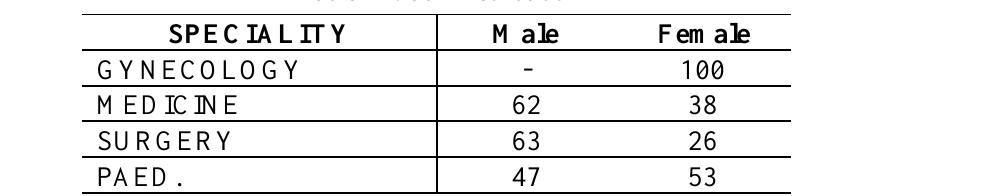
Table III : Total No. Prescriptions, % of prescriptions/specialty &